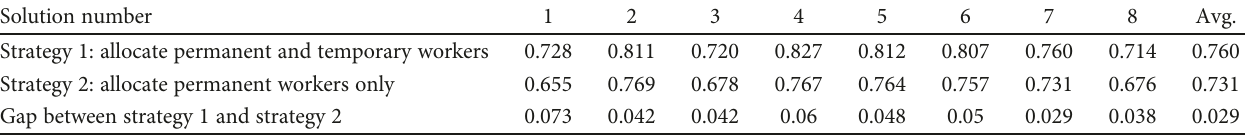
Table 4: Comparison of resource utilization rate between multiscale and single-scale resource allocation strategy.